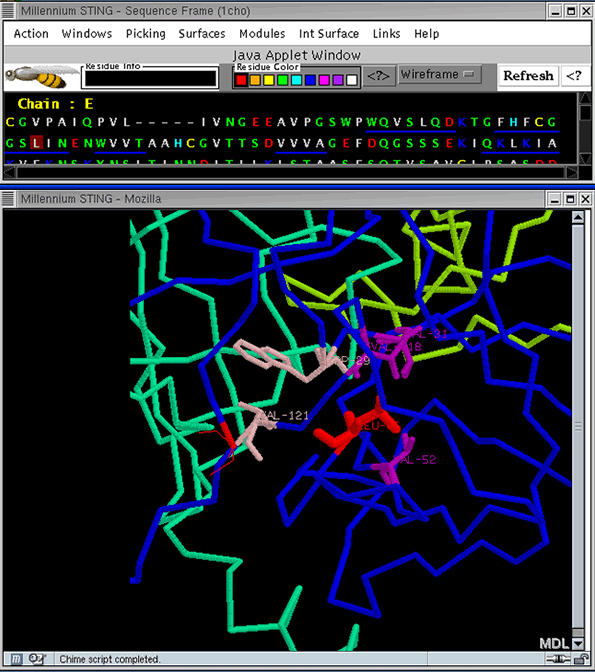
SMS sequence and structure window. This SMS example screen displays the pdb file 1cho.pdb, highlighting the residue Leu46 in chain E. SMS sequence frame, from where all the SMS modules and features can be accessed, is shown at the top of this figure. The sequence is colored according to physical-chemical properties of the amino acids. The blue and red lines underneath the amino acid sequence represent the secondary structure elements (beta strands and helices respectively), according to the pdb file annotation. As the user scrolls the mouse over the sequence, information about the residues appears in the "residue info" box. Pull-down menu on the top of the sequence frame is also shown, demonstrating choice of SMS modules and rendering. SMS structure frame (Chime wiondow) is shown at the bottom of this figure. This figure was centered on the Leu_46 (painted in red) of the E chain. The other residues drawn in stick presentation are the residues that make contacts with the Leucine, colored according to the contacts they make, corresponding to the first two lines of the Protein Dossier in Figure 2.